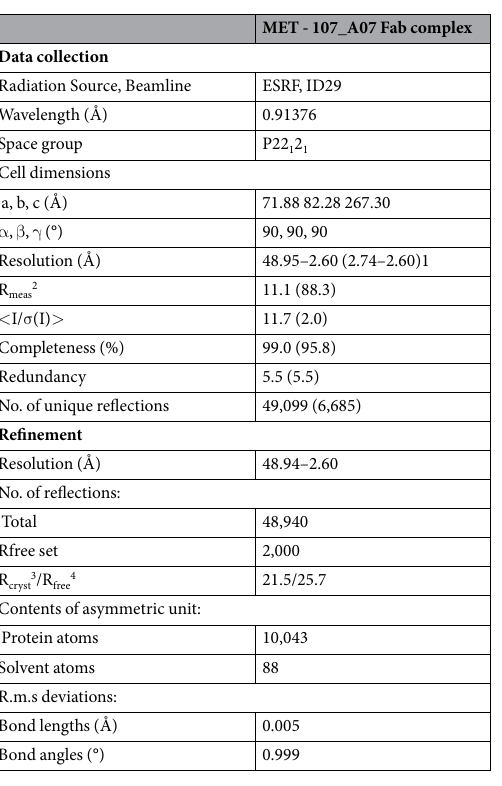
Table 1. Crystallographic data collection and refinement statistics. 1 The statistics shown in parentheses are for the highest-resolution shell. 2 R meas = ( Σ hkl [N/(N-1)] 1/2 Σ i | I i (hkl) − I mean (hkl)|)/ Σ hkl Σ i I i (hkl), where N is redundancy. 3